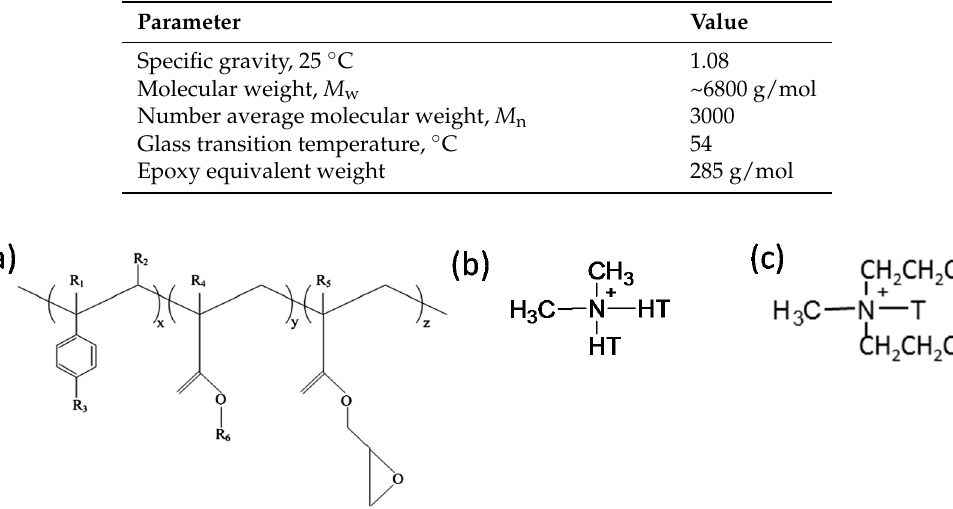
Figure 1. Chemical structure of ( a ) Joncryl ® ADR 4368, where x, y and z are between 1 and 20 R 1 , R 2 , R 3 , R 4 and R 5 are H, CH 3 , a higher alkyl group, or a combination of them; R 6 is an alkyl group [5], ( b ) dimethyl dihydrogenated-tallow quaternary ammonium and ( c ) methyl tallow bis-2-hydroxyethyl quaternary ammonium, used in the modifications of South African bentonite and modified montmorillonite (MMT), respectively. T is tallow and it is a mixture of homologs C18, C16 and C14. HT is hydrogenated tallow.